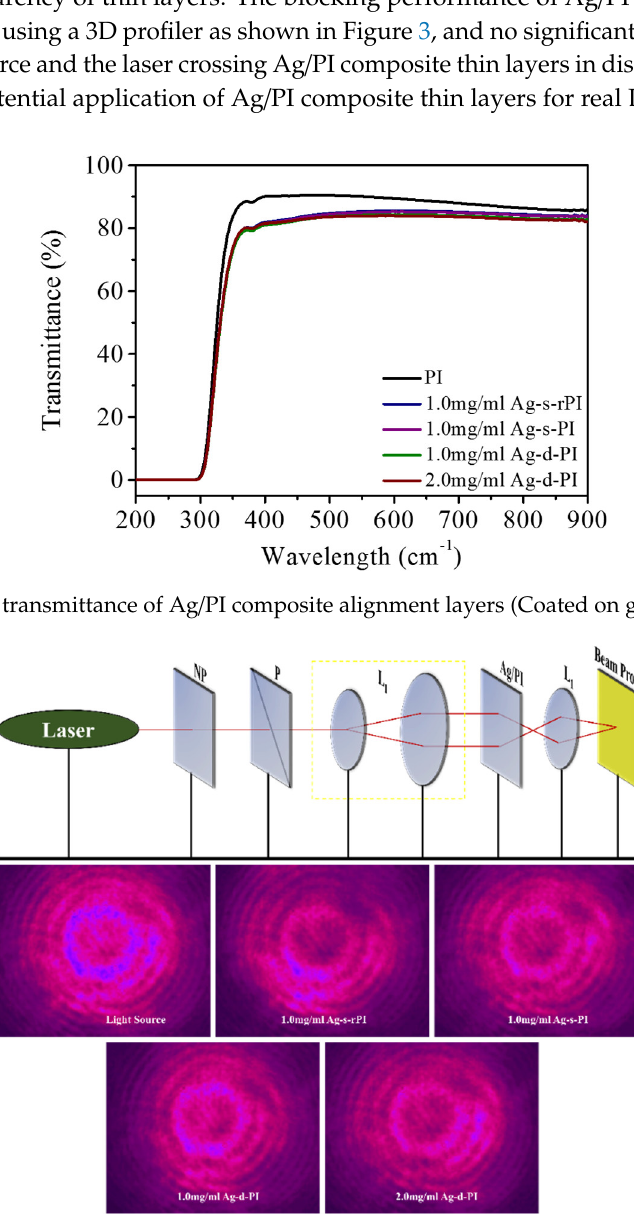
Figure 3. The schematic diagram of 3-D profiler and the captured images of laser-crossed Ag/PI alignment layers.